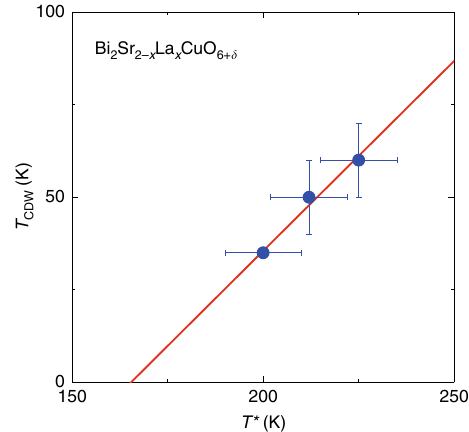
Fig. 8 Relationship between T CDW and T *. A plot of T CDW vs. T * at H = 14.5 T. The straight line is a fi tting to the data which yields a slope of 1.0 ± 0.7. Error bars represent the uncertainty in de fi ning the two characteristic